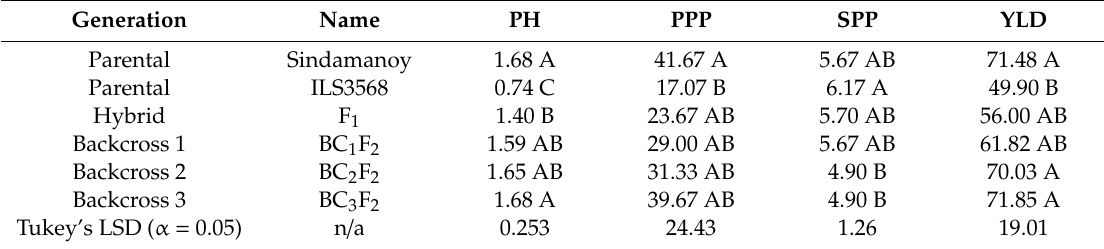
Figure 1. Representative leaf morphology and plant heights for afila selections of garden peas, from three backcross generations of the Sindamanoy (recurrent parent) × ILS3568 (donor parent) cross shown at flowering stage. Twine shown at approximately every 0.4 m of vertical distance. Table 4. Phenotypic trait measurements of plant height (PH), pods per plant (PPP), seeds per pod (SPP) and yield (YLD, in g / plant) in the parents and three backcross generations of the Sindamanoy (climbing recurrent parent) × ILS3568 (bush-type donor parent) cross with tendrilled, leafless, afila -containing BC 1 , BC 2 and BC 3 plants ( n =